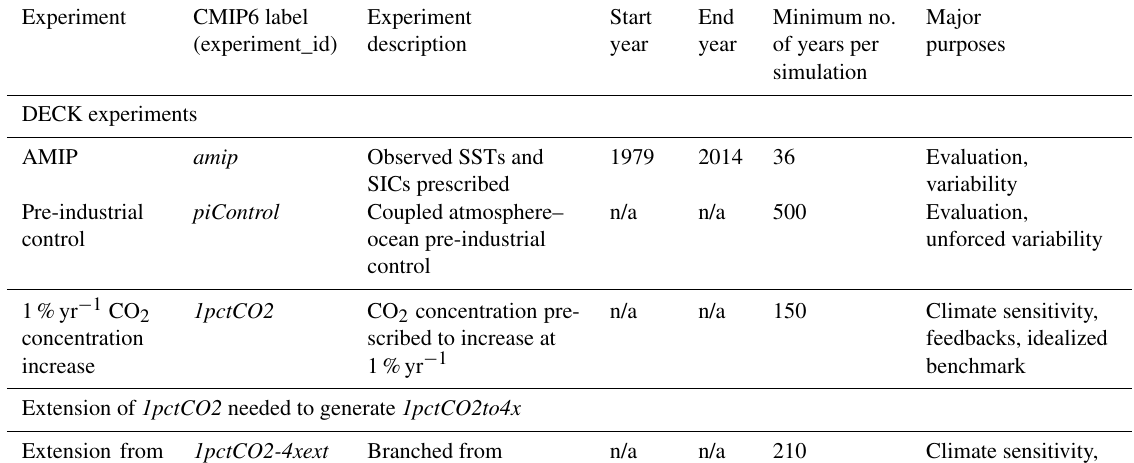
Table 1. Overview of the experiments with climate models not coupled with ice-sheet models that are to be used by ISMIP6. All experiments are started on 1 January and end on 31 December of the specified years. n/a stands for not